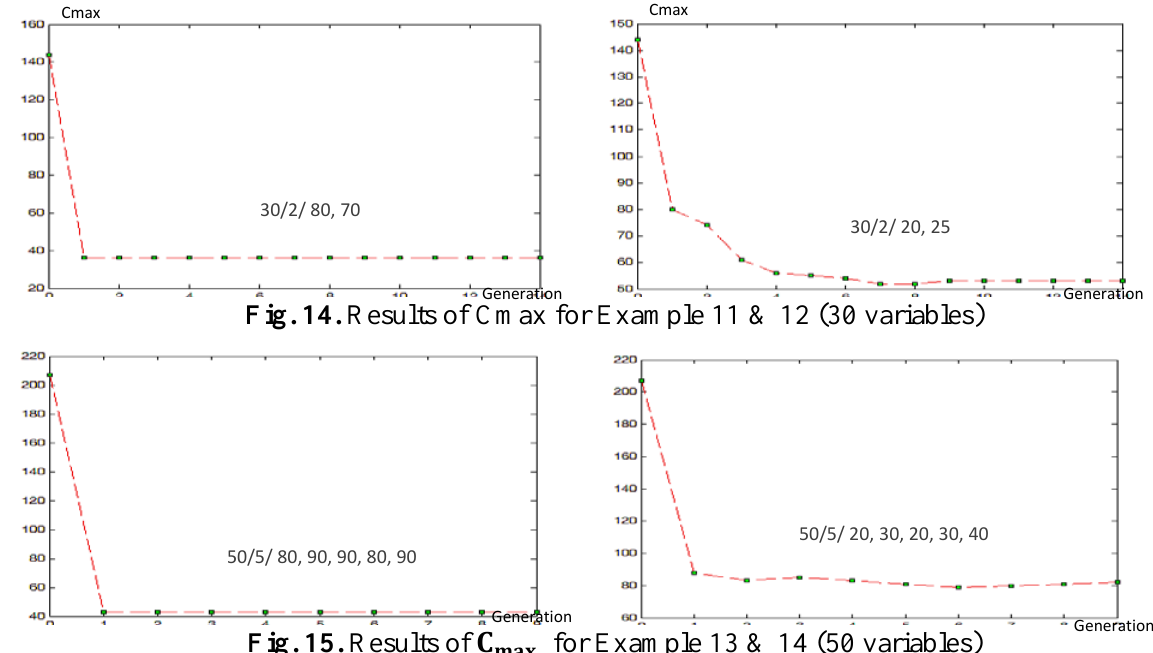
Fig. 14. Results of Cmax for Example 11 & 12 (30 variables)